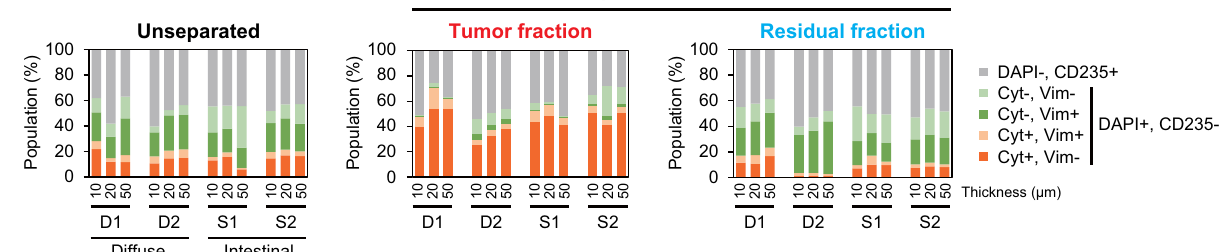
Figure 2. Estimation of tumor cell population in formalin-fixed paraffin-embedded (FFPE) tissue sections using flow cytometry. The FFPE tissue sections of different thickness (10, 20, and 50 µm) were suspended and separated using magnetic-activated cell sorting (MACS) with anti-cytokeratin microbeads. These fractions were stained with anti-cytokeratin and vimentin antibodies. To distinguish nuclei and erythrocytes, DAPI and CD235 staining were performed simultaneously. The suspensions enriched with the microbeads are defined as tumor fractions, and samples that could not be captured with these beads are designated as a residual fraction. The suspensions that were not subjected to MACS are designated as